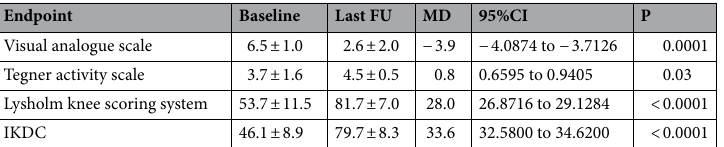
Table 3. Improvements in PROMs from baseline to the last follow-up (FU: follow-up; MD: mean difference; CI: confidence interval; IKDC: International Knee Document